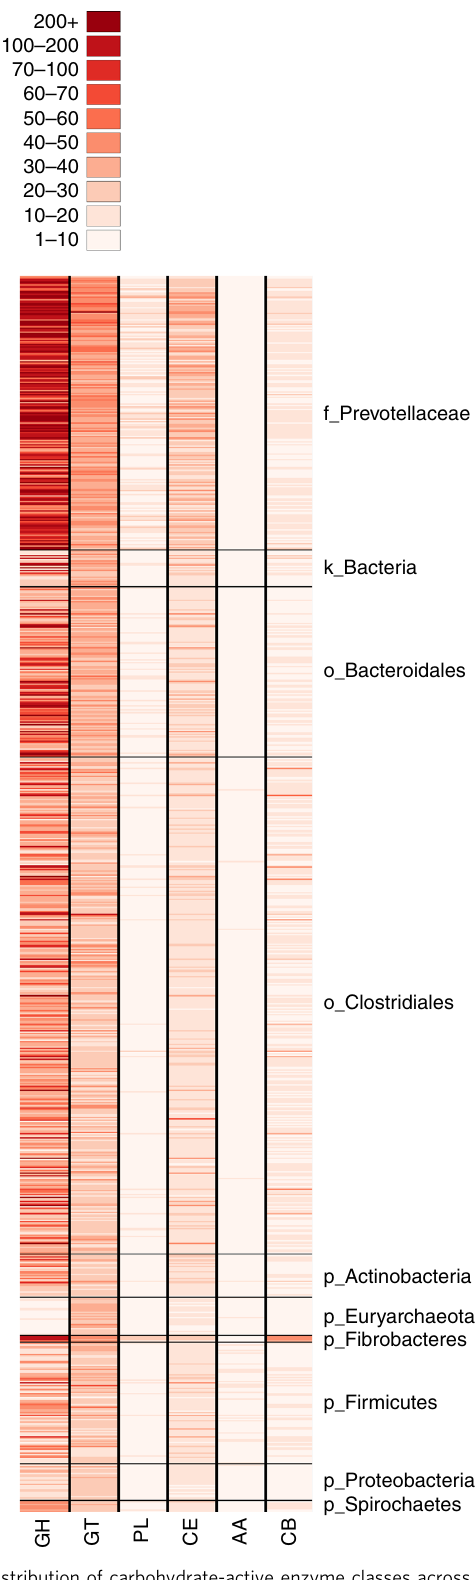
Fig. 2 Distribution of carbohydrate-active enzyme classes across the 913 RUGs. GH glycoside hydrolase, GT glycosyl transferase, PL polysaccharide lyases, CE carbohydrate esterases, AA auxiliary activities, CB carbohydrate binding. White = absent, dark red =